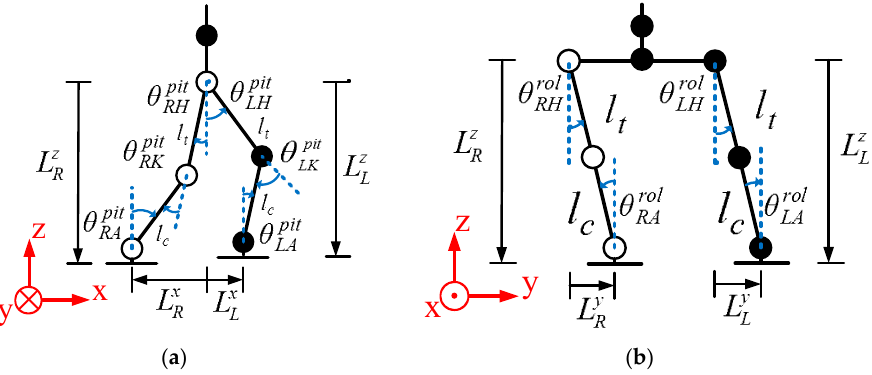
Figure 3. Coordinate systems of the humanoid robot: ( a ) sagittal plane; ( b ) frontal plane.